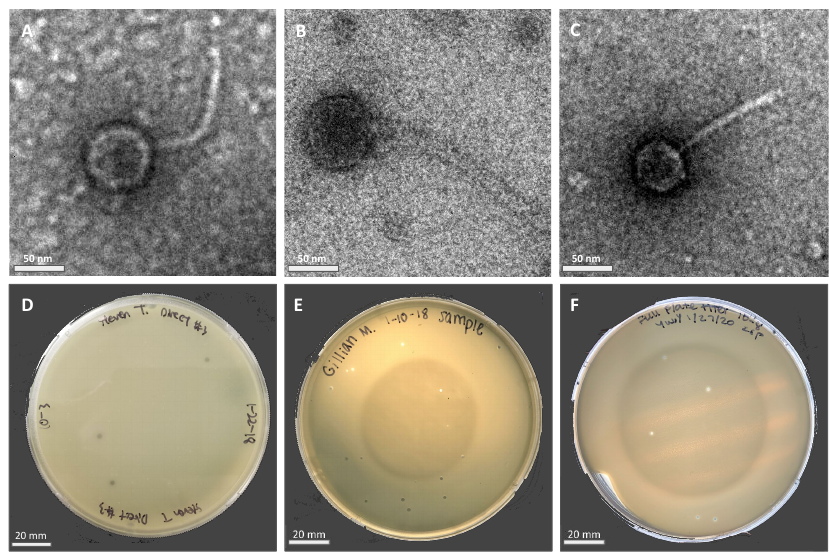
Figure 1. Electron micrographs (EM) of negatively stained Microbacterium phages with their respective plaque morphologies: ( A ) KaiHaiDragon; ( B ) OneinaGillian; ( C ) YuuY. Plaques of phages plated on M. foliorum lawns: ( D ) KaiHaiDragon; ( E ) OneinaGillian; ( F )